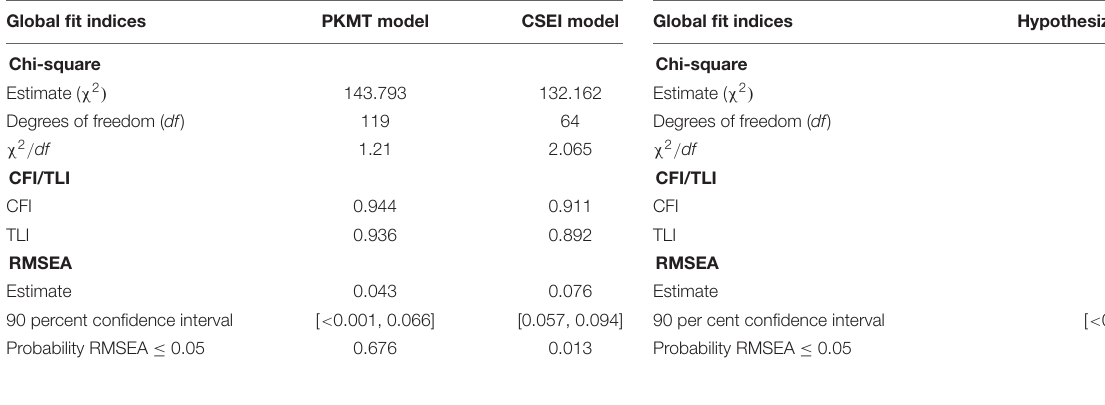
TABLE 1 | The selected global fit indices for evaluated PKMT and CSEI measurement